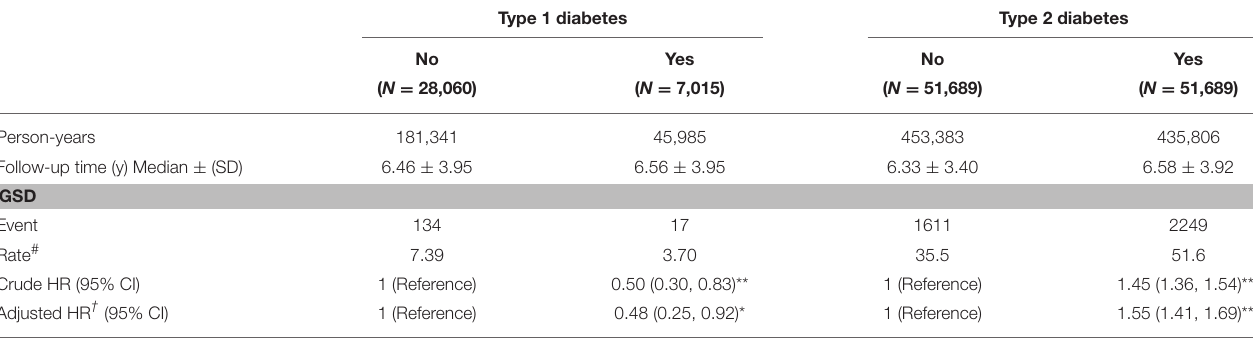
TABLE 2 | Incidence and HRs of gallbladder stone disease (GSD in type 1 diabetes cohort or type 2 diabetes cohort compared with the corresponding control cohort. Type 1 diabetes